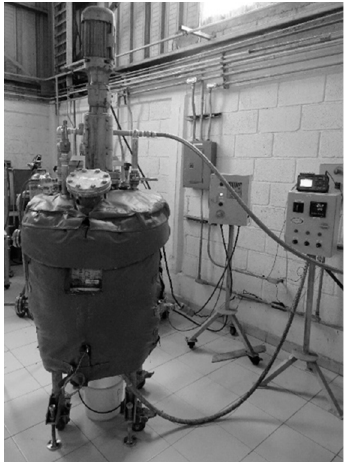
Figure 1. Batch reactor for leaching chalcopyrite concentrate.